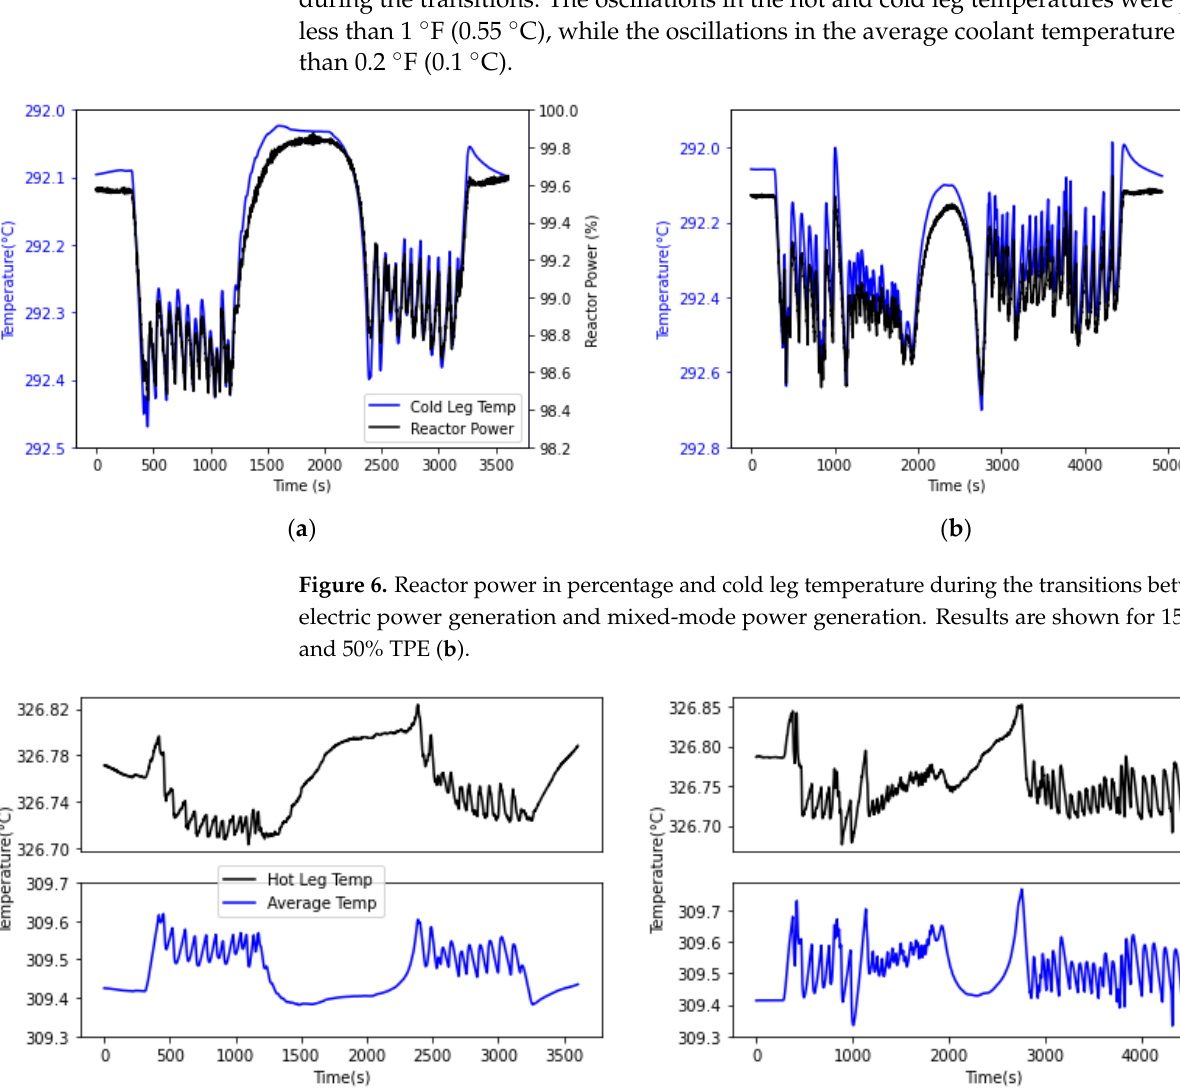
( b ) Figure 8. Pressurizer pressure and level during the transitions between pure electric power genera- tion and mixed-mode power generation. Results are shown for 15% TPE ( a ) and 50% TPE ( b ). The final items for consideration are Tavg and Tref, which are important for the con- trol rod control system. Tref is a good representation of the power in the secondary loop and is derived from the first stage impulse pressure of the high-pressure turbine. Tavg is a good representation of the power level of the primary loop, as it represents the average primary coolant temperature. As part of the modifications made to the simulator, the Tref program was adjusted to include the TPE steam flow as an additional secondary system load by calculating a fraction of the TPE flow rate as an addition to the Tref calculation based on the impulse pressure. The results for Tavg and the adjusted Tref are shown in Figure 9. The value of Tref held fairly constant until approximately 3300 s for the simula- tion with 50% thermal power extraction, and then it began to drop rapidly, indicating that